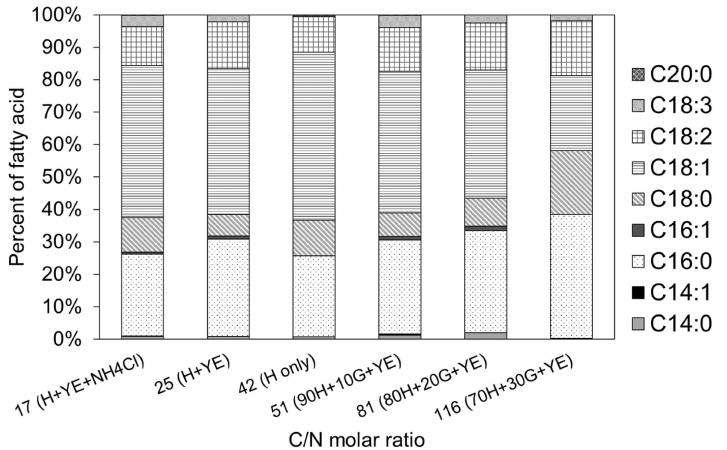
Figure 3. Fatty acid profiles when culturing R. glutinis TISTR 5159 in media with different C/N molar ratios based on addition of nitrogen sources (YE/NH4Cl) or glycerol (G), where the central value (42) represents C/N in the hydrolysate (H). Numbers in front of the letters indicate the mixing volume ratio of the hydrolysate and glycerol in the